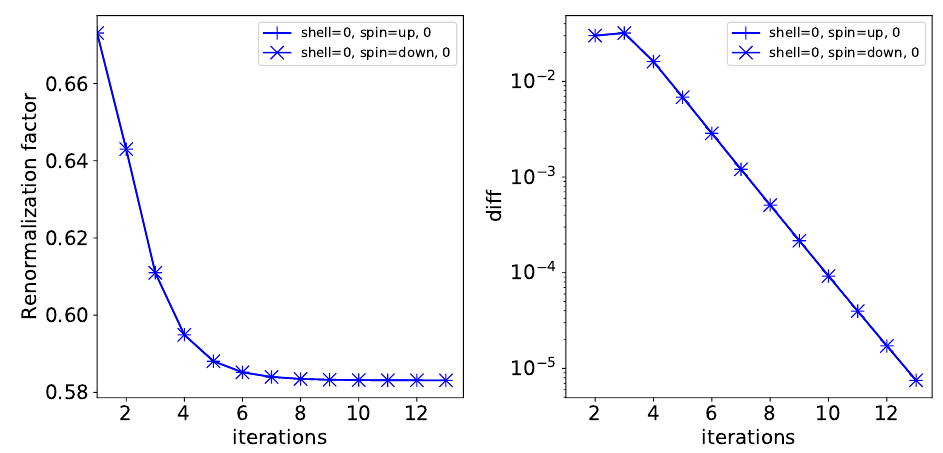
Figure 6: One of the figures generated by dcore_check for a convergence check. The renormalization factor z is plotted as a function of the iteration number (Left panel) and its absolute difference between iterations i and i − 1 is plotted in a loga- rithmic scale (Right